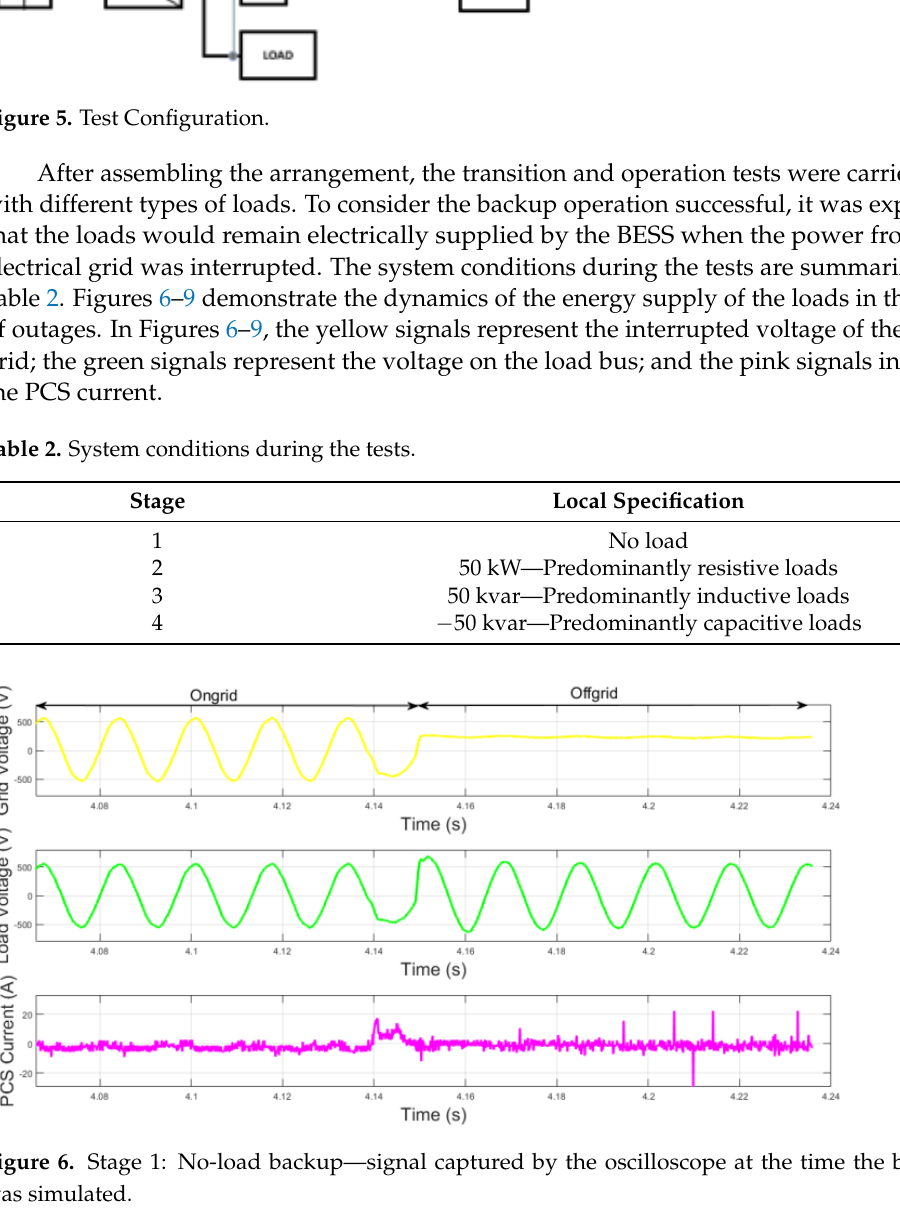
Figure 7. Stage 2: Backup on resistive loads — signal captured by the oscilloscope at the time the backup was simulated. Figure 8. Stage 3: Backup on inductive loads — signal captured by the oscilloscope at the time the backup was simulated.